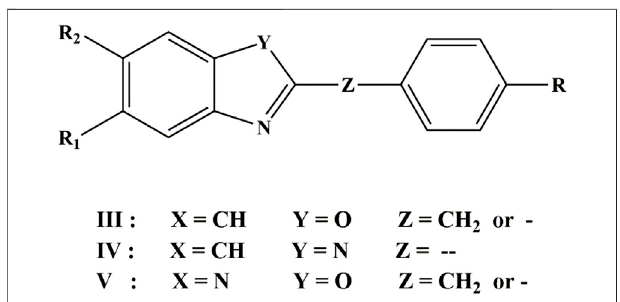
FIGURE 2 | Structures of the benzoxazole, benzimidazoles and pyridine derivatives.